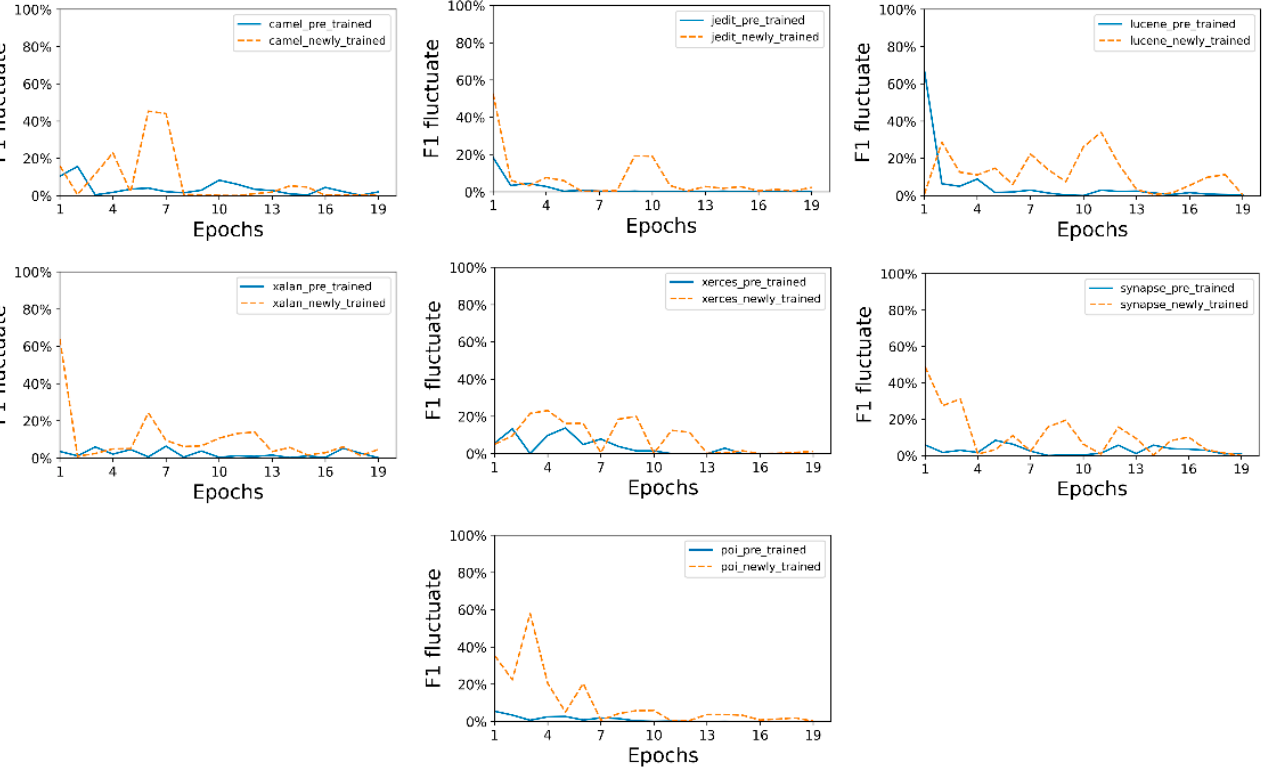
Figure 6. The fluctuating level of F-measure on CodeBERT-PT and CodeBERT-NT on the CVPSC dataset for cross-version defect prediction.